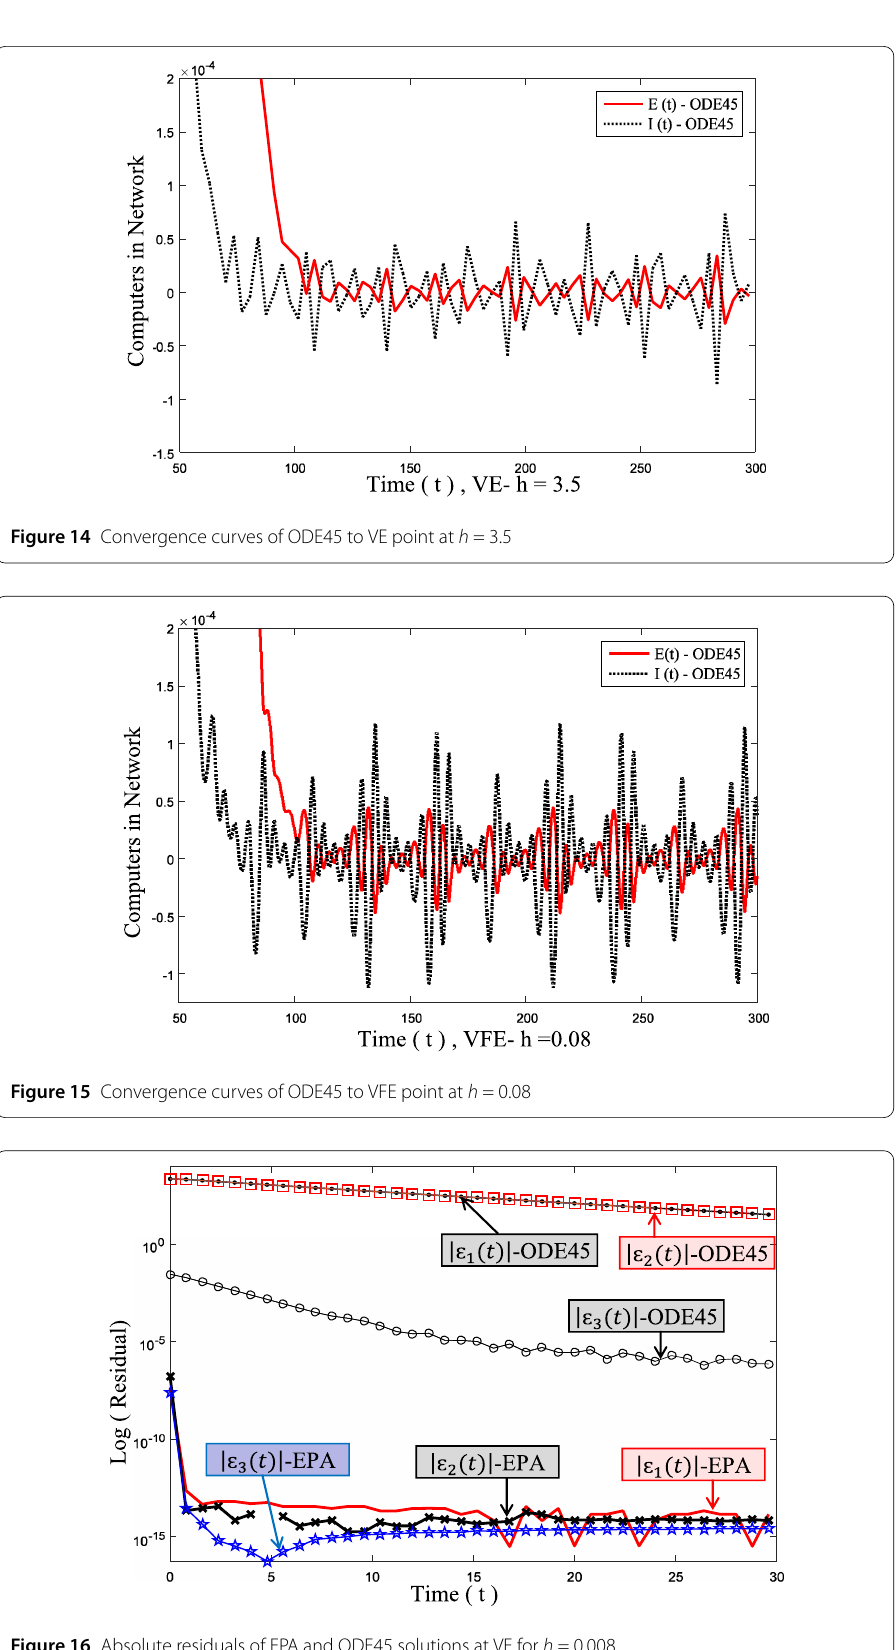
Figure 16 Absolute residuals of EPA and ODE45 solutions at VE for h =